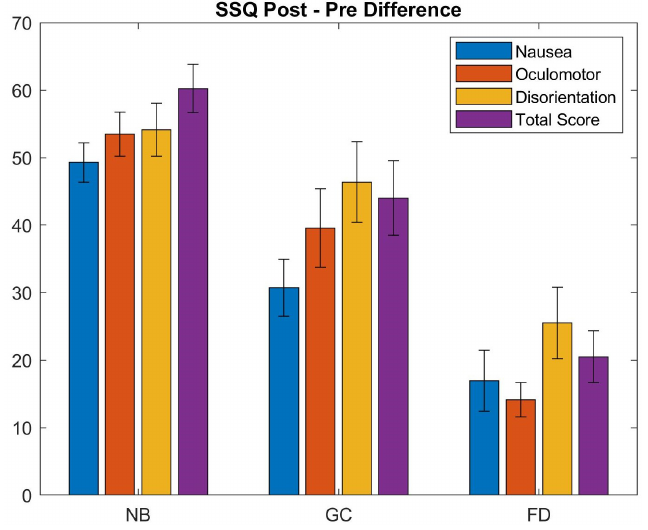
Figure 12. Comparison of the Post-Pre difference of the SSQ scores for each condition (conditions: NB—No Blur; GC—Unity Blur; FD—Ours). The plot shows the changes in individual SSQ scores between the pre and post experiment